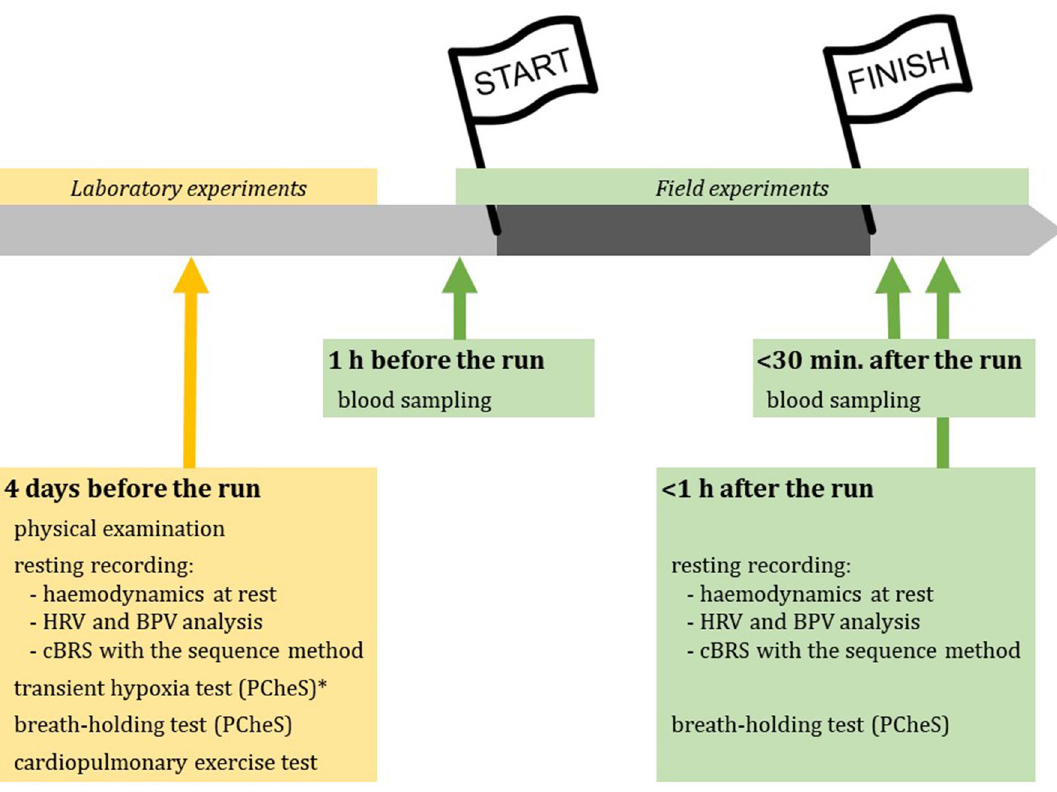
Figure 1. Schematic representation of the study